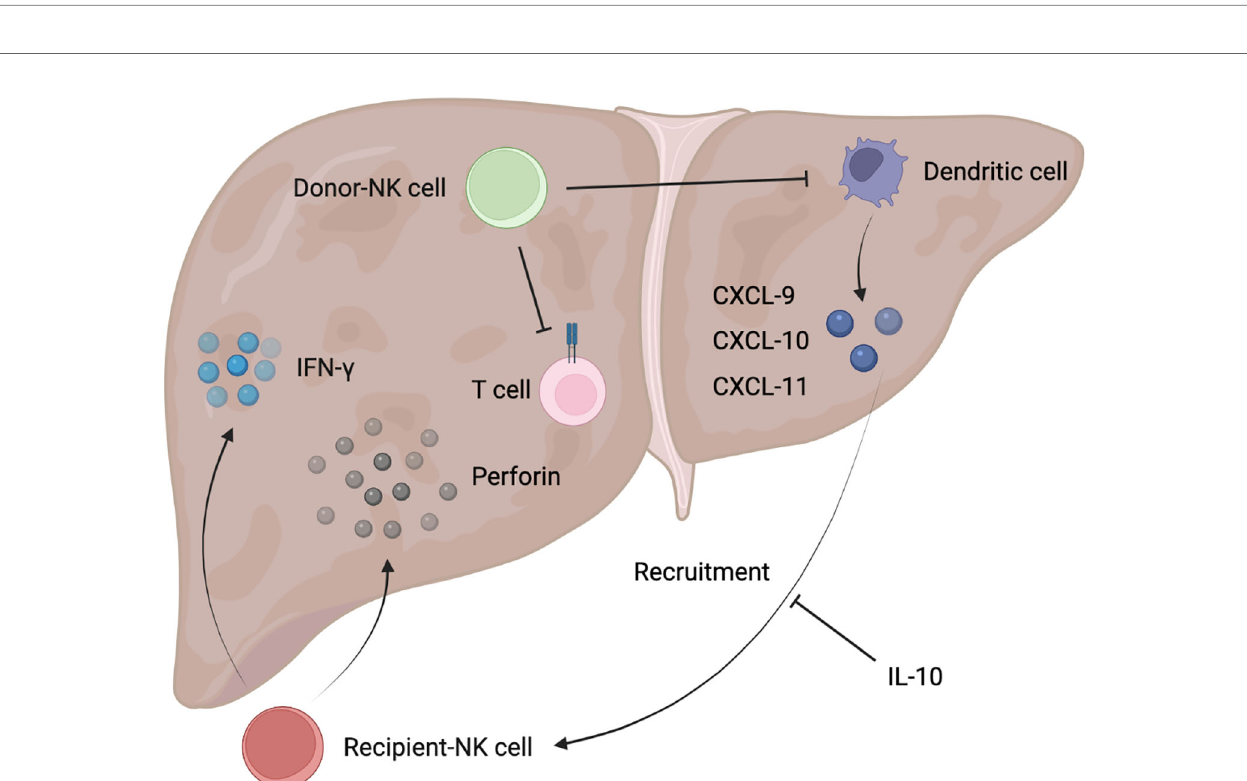
FIGURE 2 | Schematic diagram of donor/recipient-derived NK cells in immune tolerance after liver transplantation.